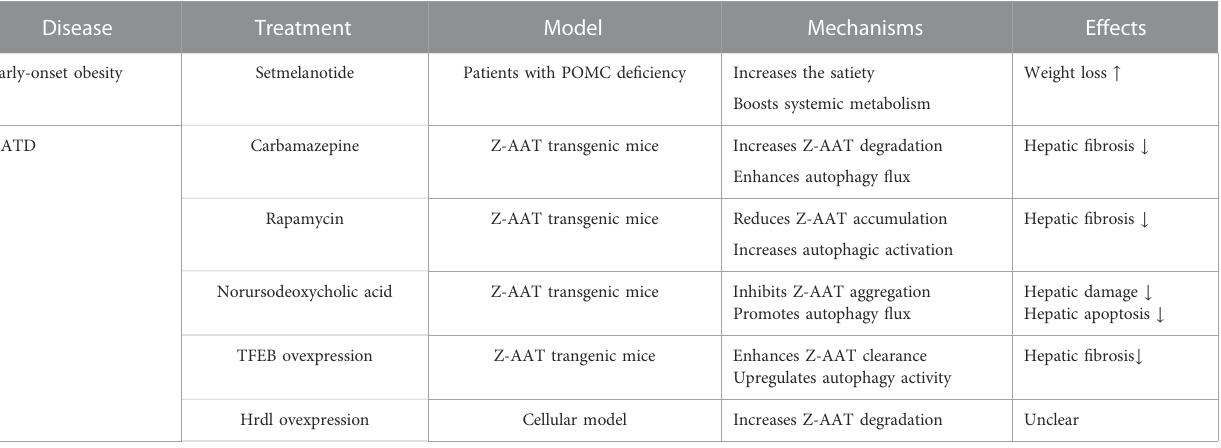
TABLE 1 Promising therapeutic strategies for representative